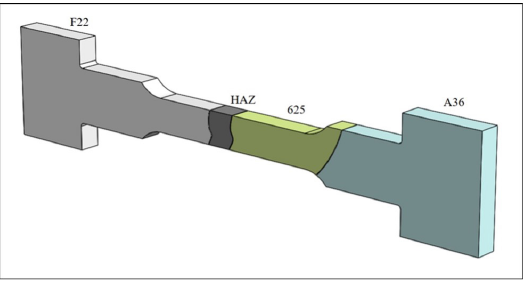
Figure 4. Tension specimen of the welded joint 11